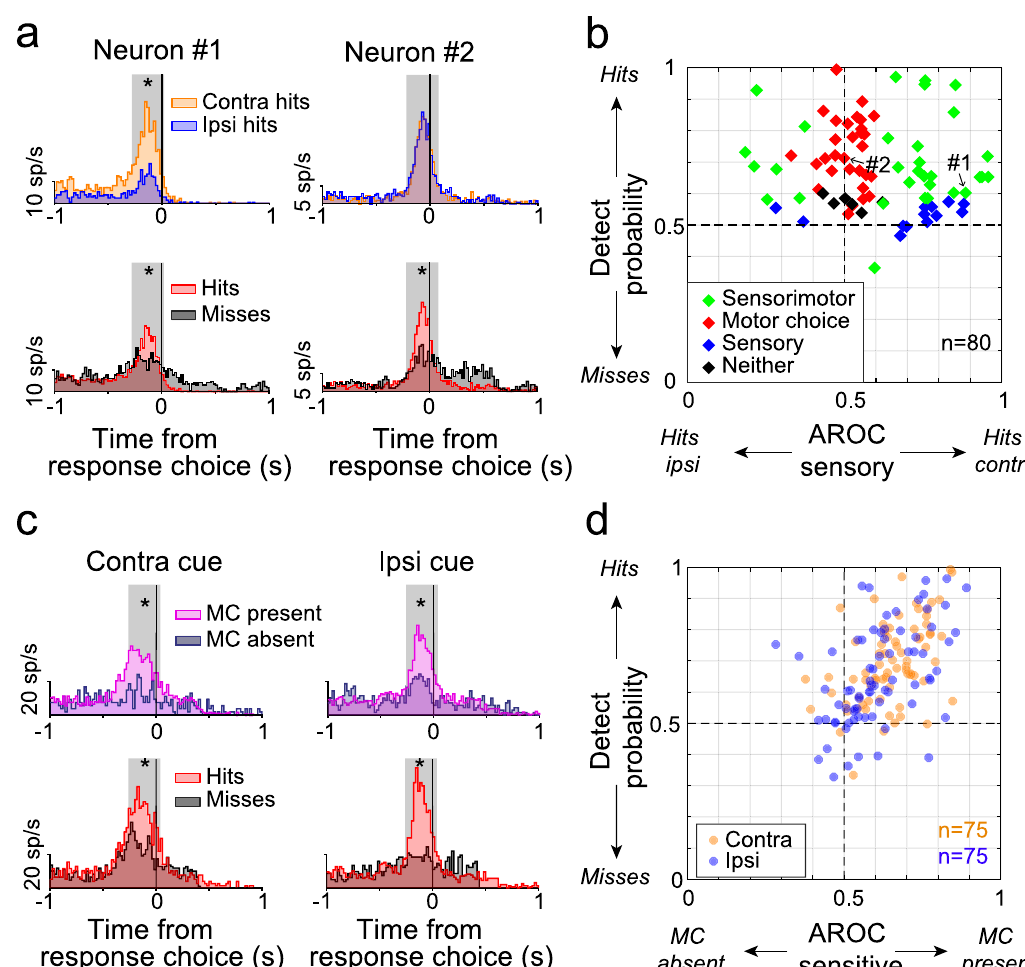
Fig 4. Response-choice activity in caudate nucleus. (A) Firing rates for two sample caudate neurons (#1 and #2) aligned on the joystick release. The upper row shows the response-choice activity for contralateral hits (“contra,” orange) and ipsilateral hits (“ipsi,” blue); the lower row shows activity for hits (red) and misses (gray) pooled across stimulus locations. Gray boxes demarcate the 0.3 s time period used for the ROC analysis. A top asterisk indicates that the AROC value was significantly different from chance level (0.5). For miss trials, which did not contain joystick releases, data for each neuron were aligned on the median reaction time during the recording session. The median reaction times were 0.56 s (IQR = 0.18, contralateral trials) and 0.53 s (IQR = 0.14, ipsilateral trials) for neuron #1 and 0.55 s (IQR = 0.13) and 0.52 s (IQR = 0.13) for neuron #2. (B) Scatter plot of detect probabilities and sensory ROC values computed for each caudate neuron that showed response-choice activity. AROC values on the x-axis greater (less) than 0.5 indicate preference for contralateral (ipsilateral) hits. Each dot represents one caudate neuron ( n = 80). Color indicates the neuron’s group assignment based on the AROC values: hits versus misses AROC different from chance (“motor choice,” red), contralateral hits versus ipsilateral hits different from chance (“sensory,” blue), both different from chance (“sensorimotor,” green), and neither different from chance (black). (C) Firing rate for one caudate example aligned on the joystick release. The upper row shows the response-choice activity in the presence (pink) or absence (blue) of the MC; the lower row shows activity for hits (red) and misses (black). For the MC-present trials (pink), the change event could happen at either location (cued or foil). The left column shows responses for the contralateral trials; the right, for the ipsilateral trials. Gray boxes demarcate the 0.3-s time period used for the ROC analysis. The top asterisk indicates that the AROC value is significantly different from chance level (0.5). For miss trials and some MC-absent trials, which did not contain joystick releases, data for each neuron were aligned on the median reaction time during the recording session. The median reaction times were 0.48 s (IQR = 0.14, contralateral trials) and 0.50 s (IQR = 0.12, ipsilateral trials). (D) Scatter plot of the detect probabilities as a function of the neural sensitivity (AROC "sensitive") for the caudate neurons with response-choice activity. Only neurons with at least five occurrences for each type of conditions were used for analysis ( n = 75/80). The color code indicates the location of the spatial cue; contralateral (orange) and ipsilateral (blue). AROC values on the x-axis greater (less) than 0.5 indicate a preference for presence (absence) of the MC; AROC values on the y-axis greater (less) than 0.5 indicate a preference for hits (misses). Underlying data available in S1 Data. AROC, area under the receiver operating characteristic curve; MC, motion change; ROC, receiver operating characteristic; sp/s, spikes per